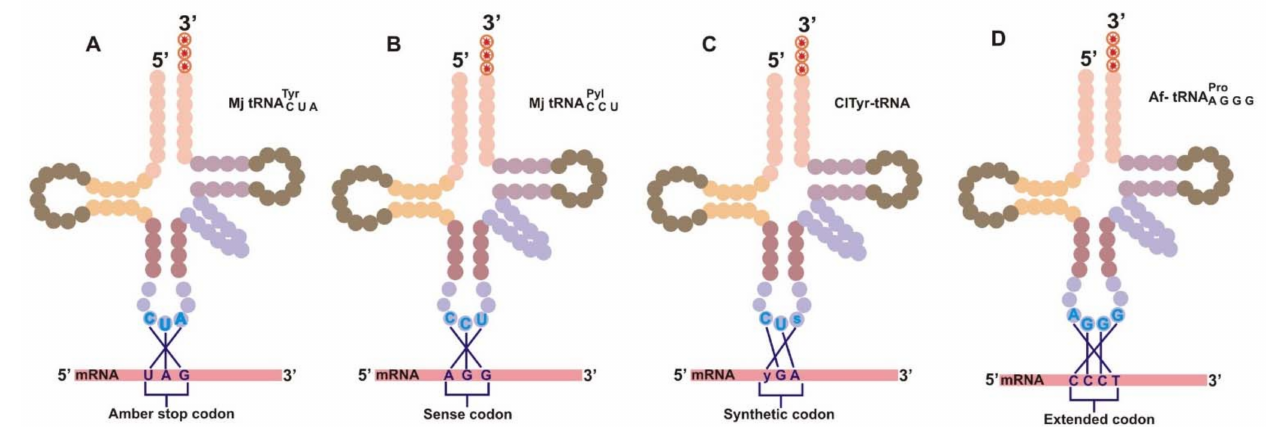
Figure 2. ( A ) Schematic illustration of the different approaches that are used for the incorporation of ncAA. ( A ) Amber codon suppression. ( B ) Rare sense codon reassignment. ( C ) Triplet codon and anticodon composed of natural and synthetic bases. ( D ) Frameshift suppression with the use of extended codon (e.g., a quadruplet